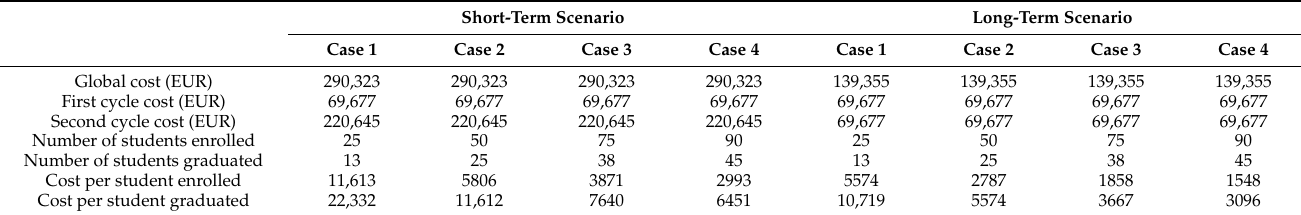
Table 4. Cost (EUR, 2019 prices) and number of students per class of graduates in short- and long-term